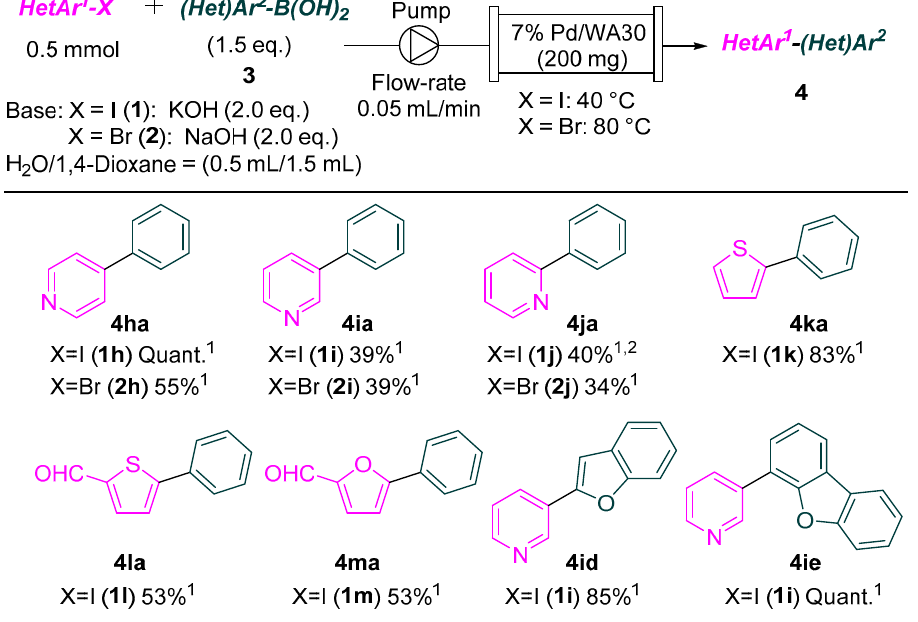
Figure 2. Scope of substrates of the 7% Pd/WA30-catalyzed continuous-flow Suzuki–Miyaura coupling reaction of (hetero)aryl iodides and bromides with (hetero)aryl boronic acids. 2.2. Continuous-Flow Suzuki–Miyaura Coupling of Aryl Chlorides with Aryl Boronic Acids